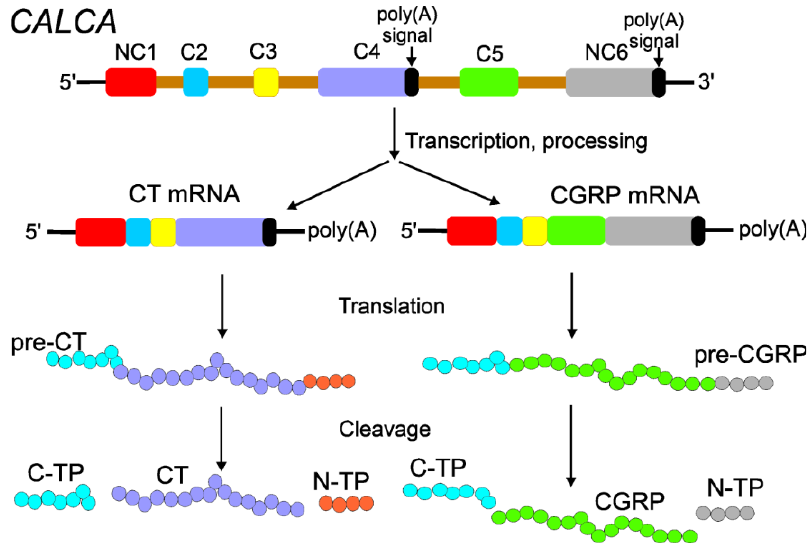
Figure 3. Alternative processing of the CALCA gene produces calcitonin (CT) and the calcitonin gene-related peptide (CGRP). The CALCA gene has 6 exons separated by 5 introns (gold). Exons 1 and 6 are non-coding exons (NC1, NC6), whereas exons 2–5 are coding exons (C2–C5). Exons 4 and 6 contain signals for polyadenylation (poly(A) signals) that are linked with termination signals in the transcription of the CALCA gene. Therefore, two different CALCA pre-mRNAs having common NC1 + C2 + C3 regions are produced, bearing polyadenylated (poly(A)) tails at their 3′ ends. These two mRNAs are then spliced to produce CT mRNA with four first exons with a poly(A) tail at the 3′ end of exon 4 and CGRP mRNA with three first exons plus exons 5 and 6 with a poly(A) tail at its 3′ end. These two mRNAs are translated to produce CT and CGRP precursors. Post-translational cleavage results in functional CT and CGRP proteins as well as N- and C-terminal peptides (N-TP and C-TP, respectively).